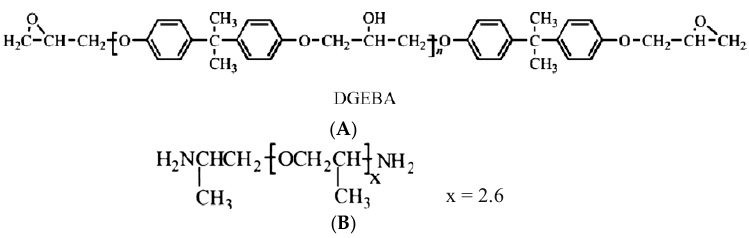
Figure 1. Molecular structure of ( A ) diglycidyl ether of bisphenol ‐ A (DGEBA) and ( B ) of aliphatic polyoxypropylene diamine (Jeffamine ® ).